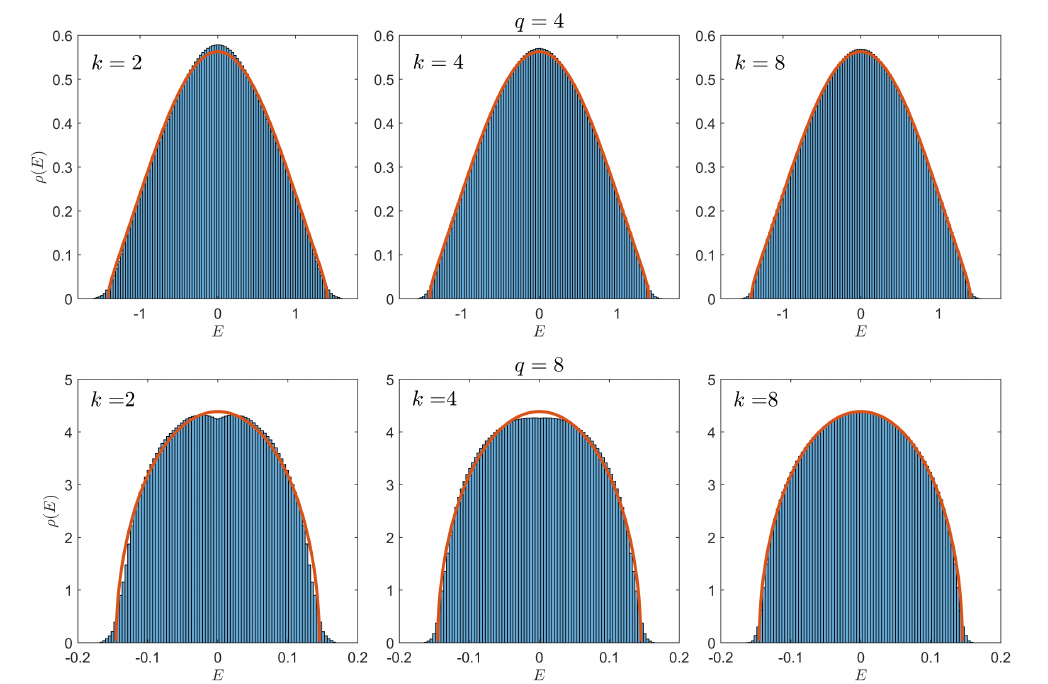
Figure 1 . Histograms of the spectral density of the sparse SYK Hamiltonian for N = 30 and various values of k . The spectral density is averaged over 100 disorder realizations. For comparison the solid red line is the Q –Gaussian approximation to the spectral density